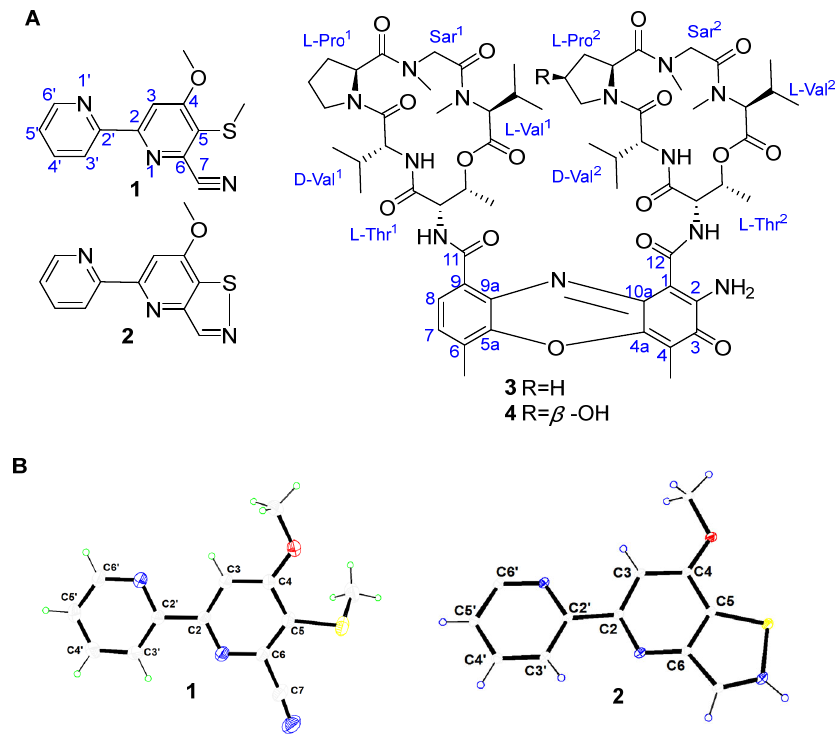
Figure 2. The structures of compounds 1 – 4 ( A ) and compounds 1 and 2 by X ‐ ray crystal ( B ). For compounds 3 and 4 , the molecular formulas were identified as C 62 H 86 N 12 O 16 and C 62 H 86 N 12 O 17 due to the HRESIMS peaks at m / z 1255.6355 and 1269.6269. The 62 carbon signals of compounds 3 and 4 in the 13 C NMR spectrum, combined with the UV absorp ‐ tions at 256 nm and 442 nm, indicated the actinomycin skeleton of the compounds. The structures of the compounds were determined to be actinomycin D ( 3 ) and actinomycin X O β ( 4 ) from the comparison of the NMR data (Table S4) with the compounds we isolated previously